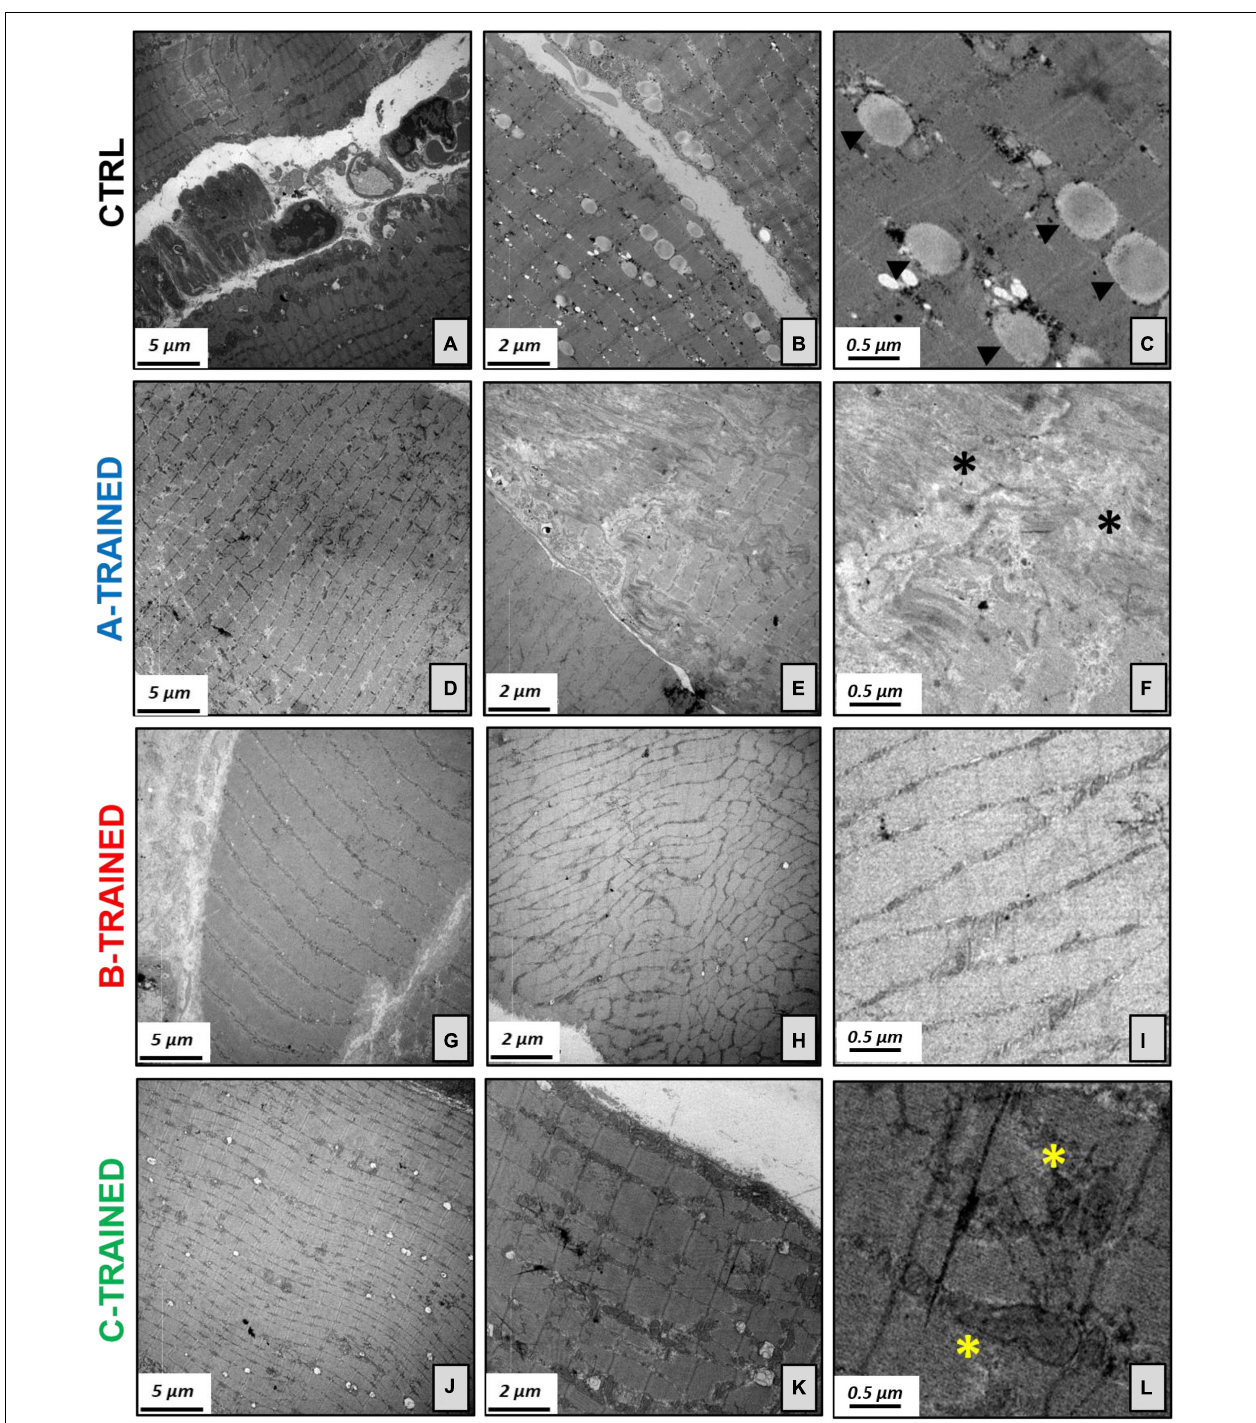
FIGURE 3 | Electron microscopy analysis of the muscle tissues following WBV training. (A) Image displays degenerated sarcomeric network of CTRL groups, (B) with numerous lipid droplets and increase in atrophic fibers. (C) Electron micrograph shows several lipid droplets (arrowheads) next to mitochondria. (D) Muscle tissue of the A-TRAINED group was characterized by altered sarcomeric structures, (E) abundant inter-fiber fibrosis and presence of atrophic muscle fibers. (F) Enlargement of panel (E) highlights the fibrotic tissue (asterisks). (G) Image shows an improvement in muscle tissue fibers in the B-TRAINED group, (H) with the presence of normal fibers alternating with slightly atrophic ones. (I) Image displays a sarcomeric ultrastructure in a muscle of B-TRAINED mouse. (J) Muscle tissue of the C-TRAINED group shows normal sarcomeric structures, (K) with numerous and well-preserved mitochondria. (L) Enlargement of panel (K) highlights well-preserved dark mitochondria (asterisks) in a muscle of C-TRAINED mouse. Scale bar, 5, 2, and 0.5 µ m.